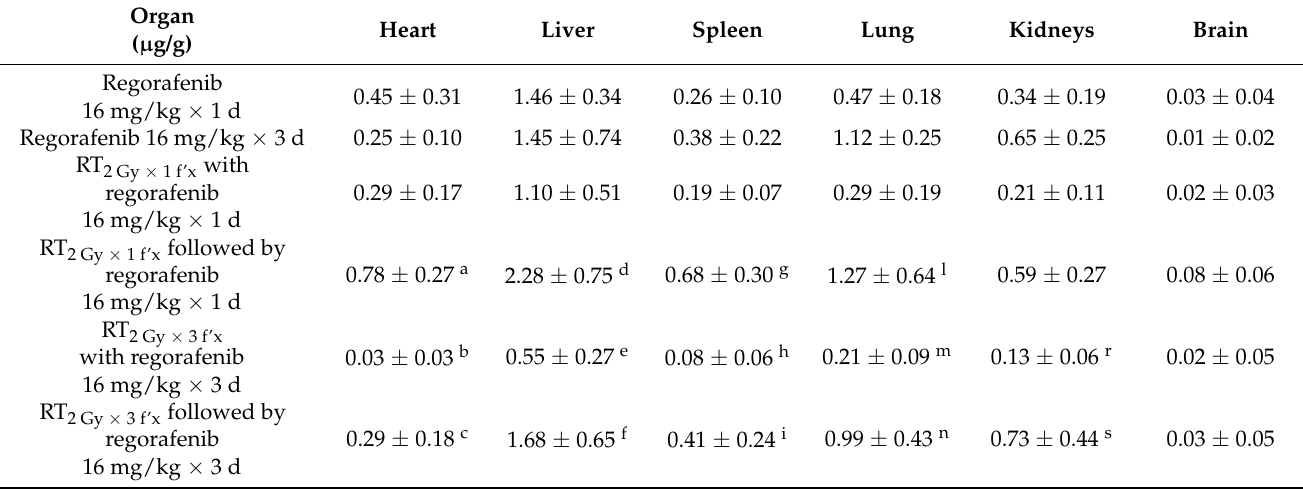
Figure 4. The concentrations ( µ g/g) of regorafenib in different organs were collected after oral administration for 4 h. The regimens included ( A ) RT 2 Gy × 1 f’x and RT 2 Gy × 3 f’x or ( B ) RT 9Gy × 1 f’x and RT 9 Gy × 3 f’x , with or without regorafenib, at a dose of 16 mg/kg, concurrently or sequentially. Data are expressed as the mean ± SEM ( n = 6 for each group). Table 2. Concentrations of regorafenib in the heart, liver, spleen, lung, kidney and brain of rats after administration (16 mg/kg, p.o.) with or without radiotherapy.